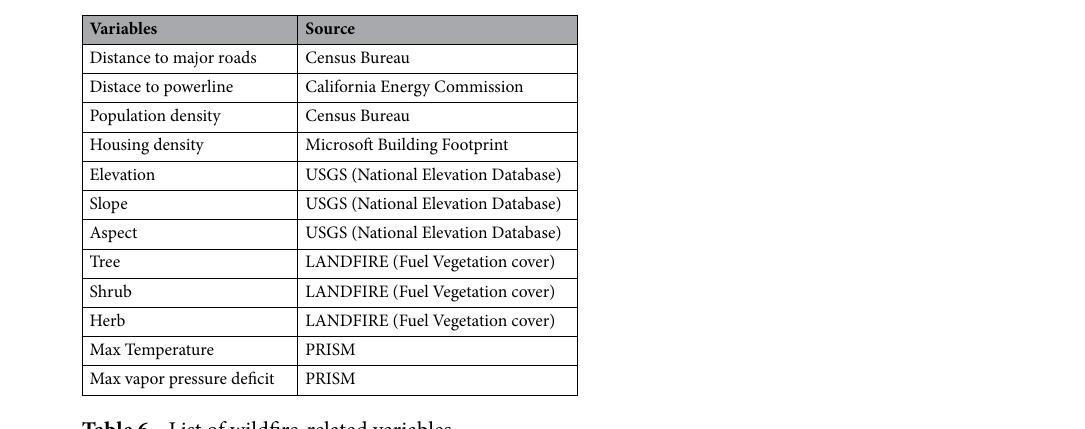
Table 6. List of wildfire-related